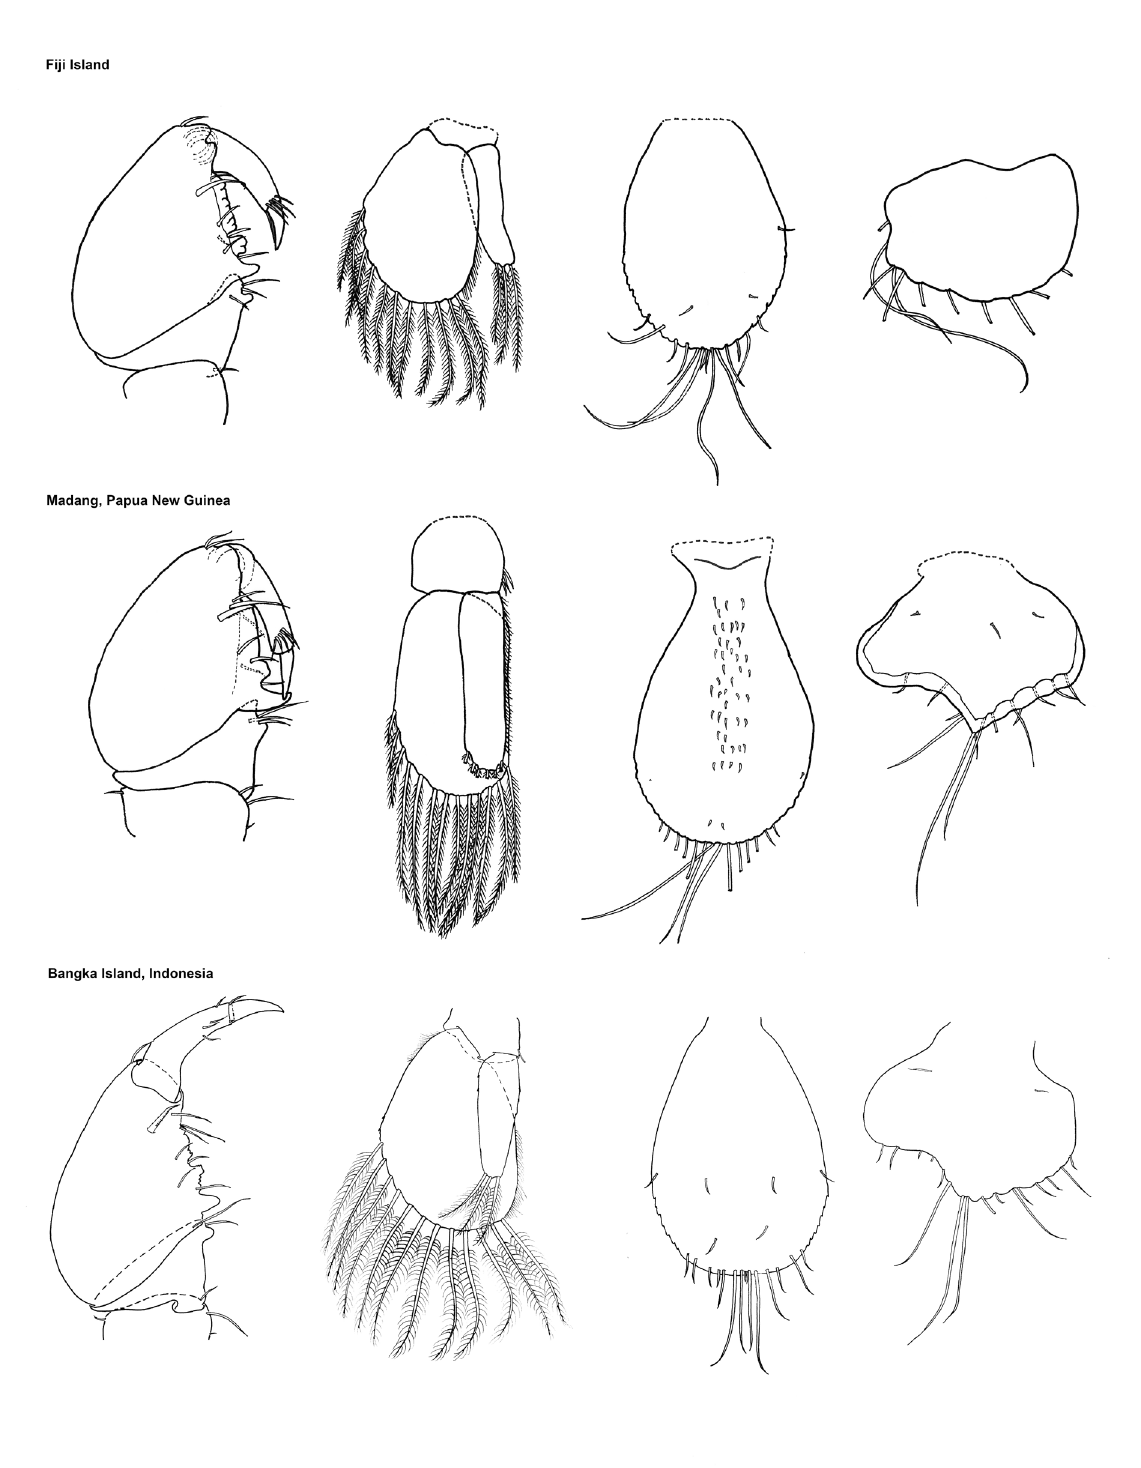
Fig. 23. Expanathura collaris (Kensley, 1979), comparison of published descriptions.pereopod 1, pleopod 1, telson and exopod of uropod. Populations from Fiji (after Negoescu 1999), Madang (after Negoescu and Brandt 2001) and Bangka Island (present